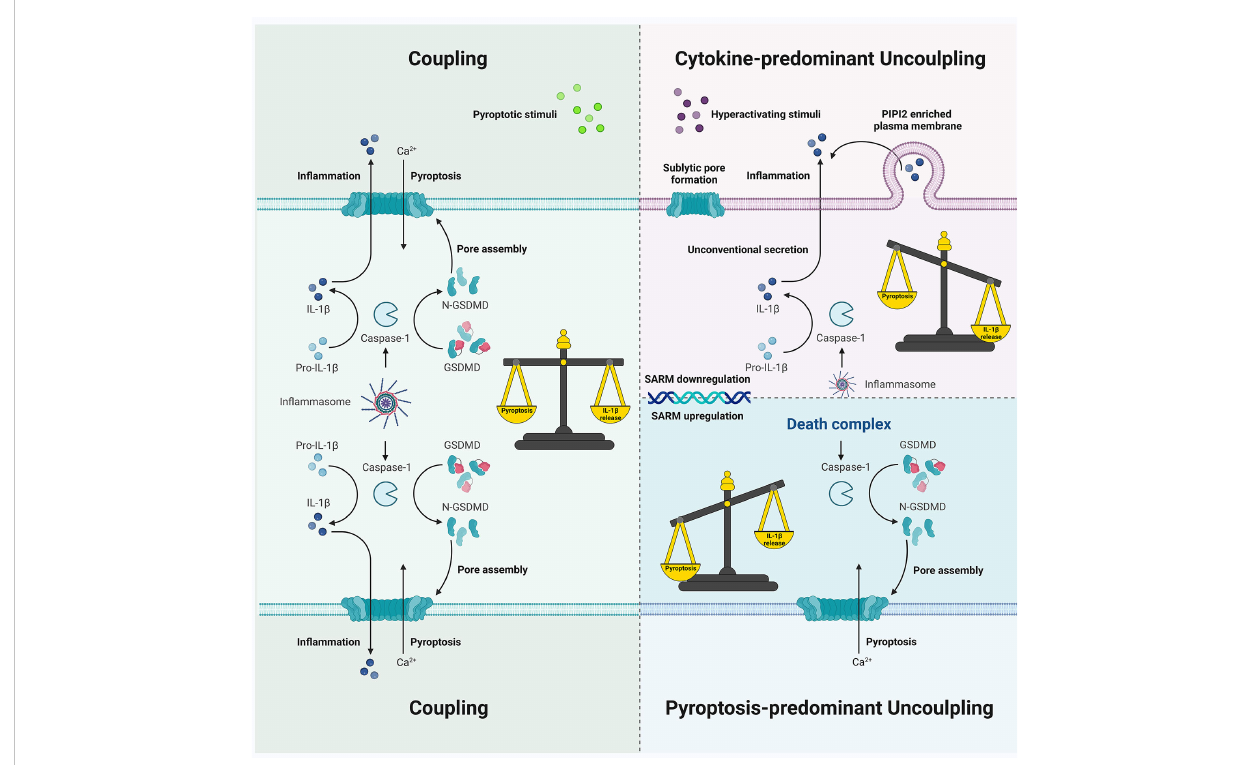
FIGURE 5 Schematic showing coupling and uncoupling events downstream of in fl ammasome signaling. Pyroptotic death and IL-1 b secretion are commonly coupled as simultaneous consequences of in fl ammasome activation. Cytokine-predominant uncoupling is observed in hyperactivating stimuli challenges with mechanisms that depend on GSDMD pores or GSDMD molecules but not the pore formation on the plasma membrane; SARM de fi ciency may be involved in unconventional IL-1 b secretion without pyroptosis in certain cell types. In contrast, death complex exhibits a pyroptosis-predominant uncoupling preference, which may be due to the differential behavior of active caspase-1 species during in fl ammasome